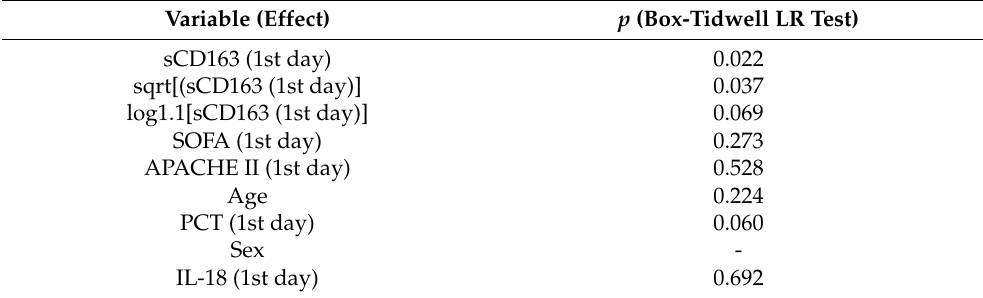
Table A2. Assessment of the linearity between the predictors and the logit of the risk of in-hospital death in septic patients.